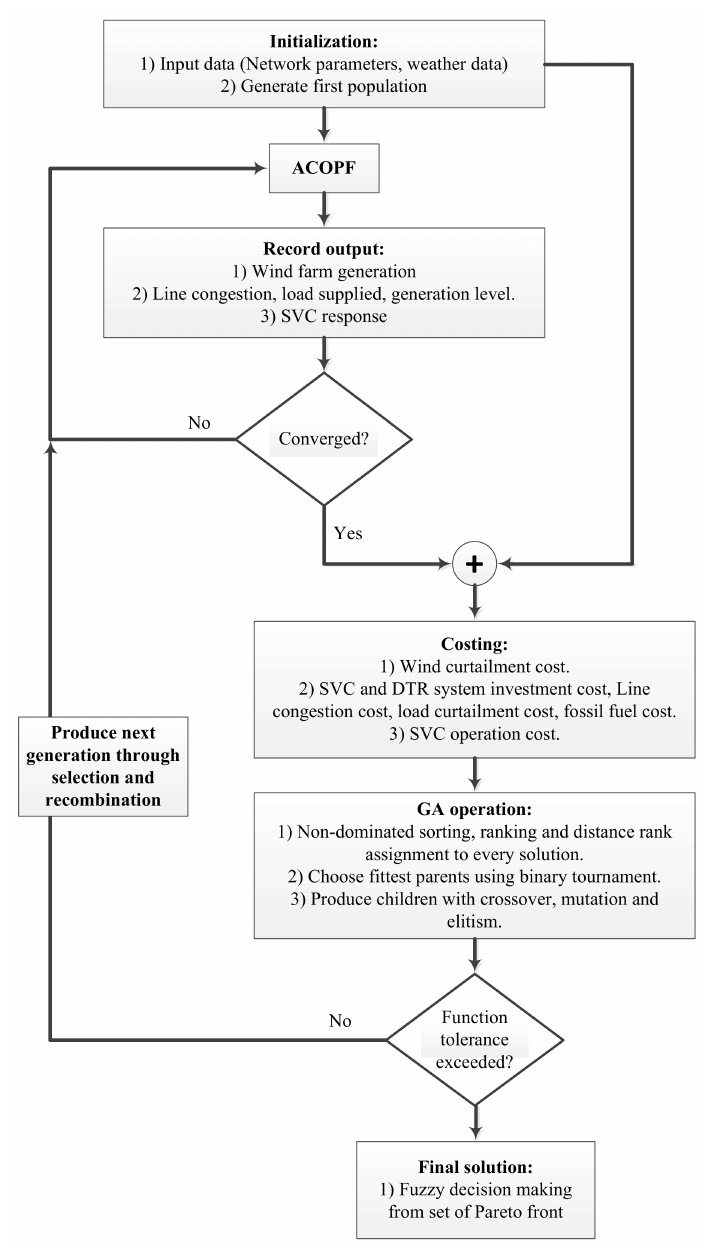
Figure 2. Flowchart of the proposed algorithm. ACOPF: alternating current optimal power flow; DTR: dynamic thermal